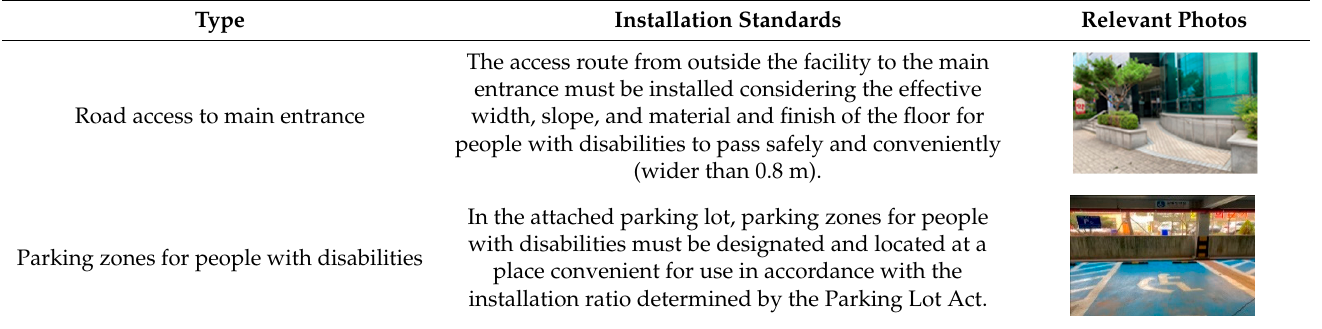
Table 1. Type and installation standards of convenience facilities for people with disabilities *.